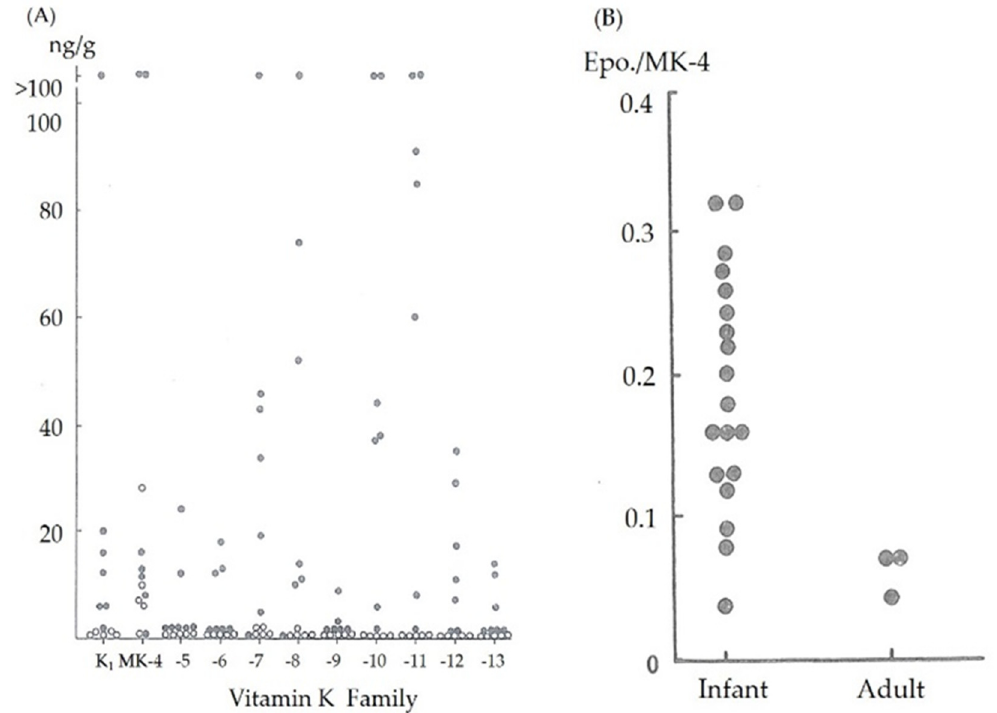
Figure 1. ( A ) Vitamin K (K 1 , or phylloquinone and menaquinone (MK)) content in the liver tissue in adults (closed circles) and neonates (open circles) without definite liver dysfunction. ( B ) Menaquinone-4 2, 3-epoxide/menaquinone-4 (Epo./MK-4) ratio after vitamin K (MK-4) loading in normal adults and 1-month-old infants. Table 1. Vitamin K content (mg / L) of human, cow, and formula milk.